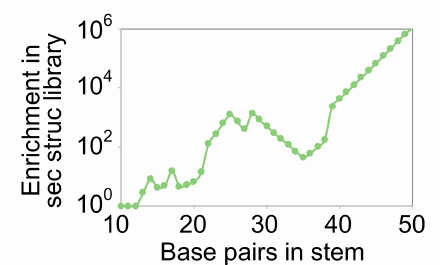
Figure 5. Enrichment of stem variants in secondary structure libraries relative to randomly mu- tagenized libraries. The optimal coding strategy for base pairs and the optimal rate of random mutagenesis was determined for a series of stems containing 10 to 50 base pairs. Enrichment of distinct variants of the stem in the secondary structure library ( y axis) was calculated by dividing the number of different variants of the stem expected to occur in a secondary structure library (generated using the optimal coding strategy for base pairs) by the number expected to occur in a randomly mutagenized library (generated using the optimal rate of mutagenesis). Calculations were performed for a library of 10 15 sequences. The breakpoints in this graph are due to changes in the maximum number of mutations a sequence can contain to be present in the library.